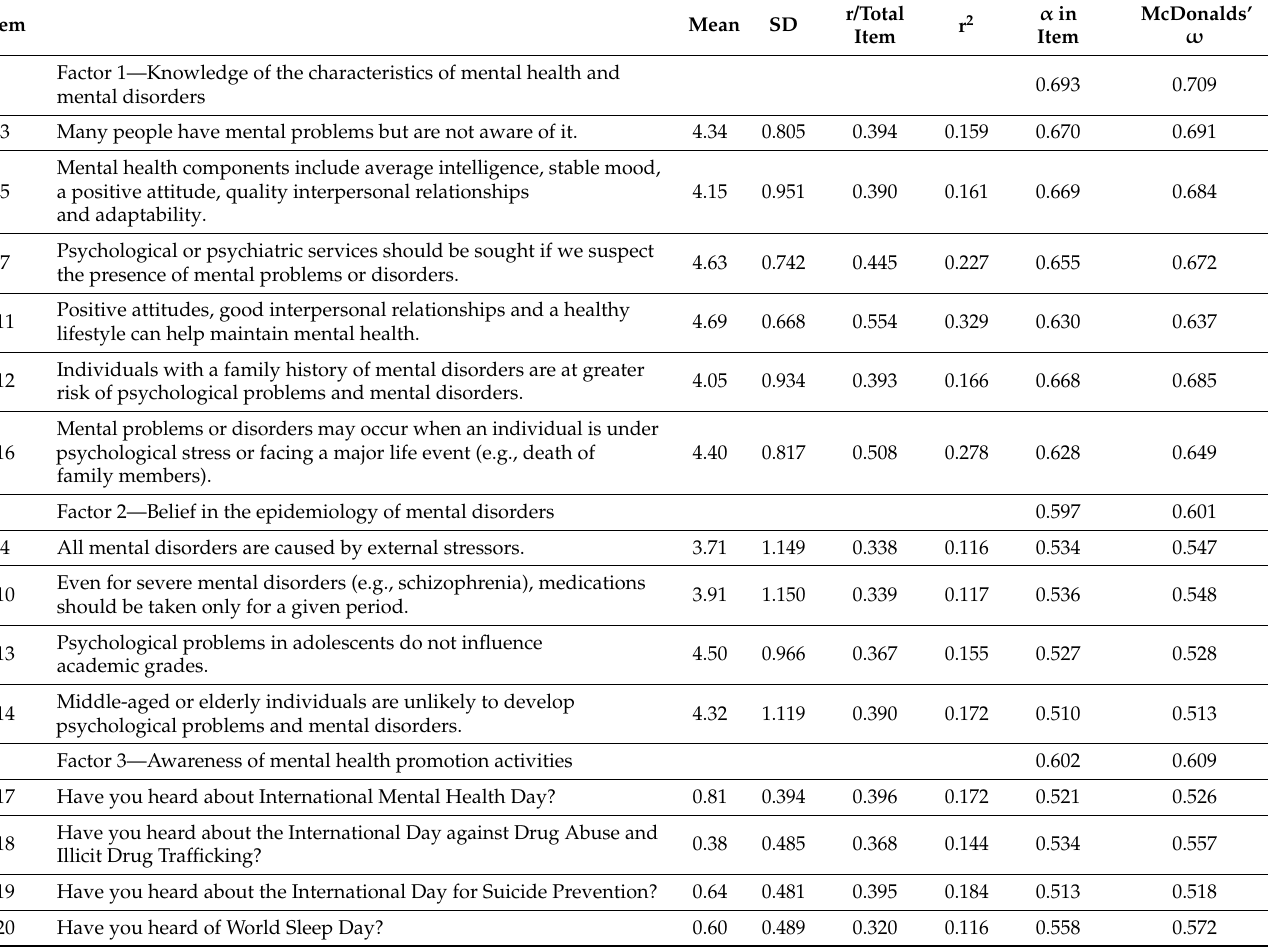
Table 5. Internal consistency of each factor of the Mental Health Knowledge